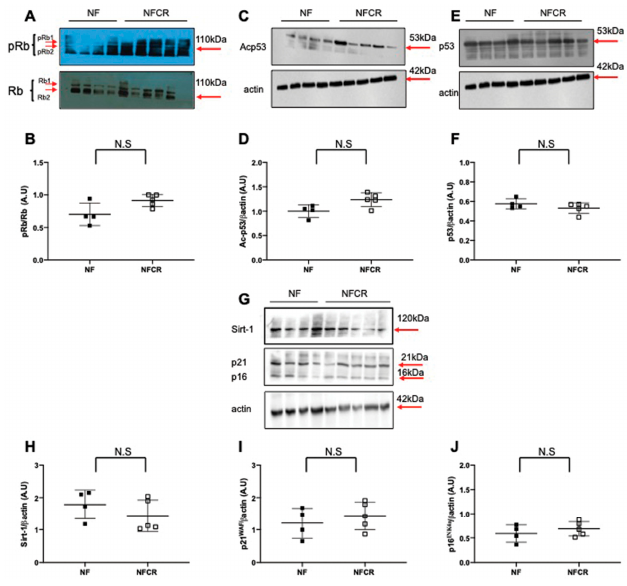
Figure 6. Hepatic senescence in animals in the NF and NFCR groups at seven months. Liver protein levels of p-Rb / Rb ( A , B ), Ac-p53 ( C , D ), p53 ( E , F ), Sirt-1 ( G , H ), p21 WAF ( G , I ) and p16 INK4a ( G , J ) were measured by western blot in the NF and NFCR groups. Values are reported as the mean ± SD; N.S: nonsignificant, p > 0.05; n = 5–4 animals/group.